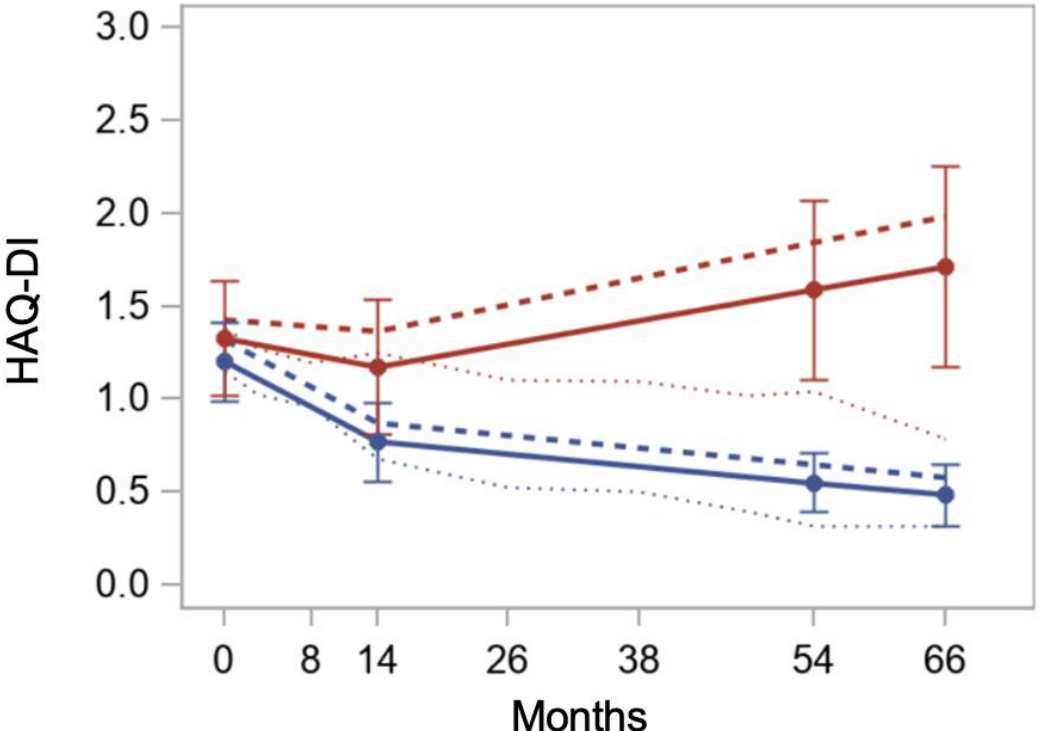
Figure 4. Longitudinal trend over 66 months from randomization for quality of life, as measured by the Health Assessment Questionnaire Disability Index (HAQ-DI) for patients undergoing autologous hematopoietic cell transplantation (autoHCT: blue line) vs. conventional therapy (12 monthly infusions of cyclophosphamide: red line) [68]. The HAQ-DI improved (became lower) in the autoHCT patients, whereas it worsened in the conventionally treated patients. Reproduced with permission from Wiley Global Publishing, Arthritis Care and Research , published by Wiley Publishing Global,